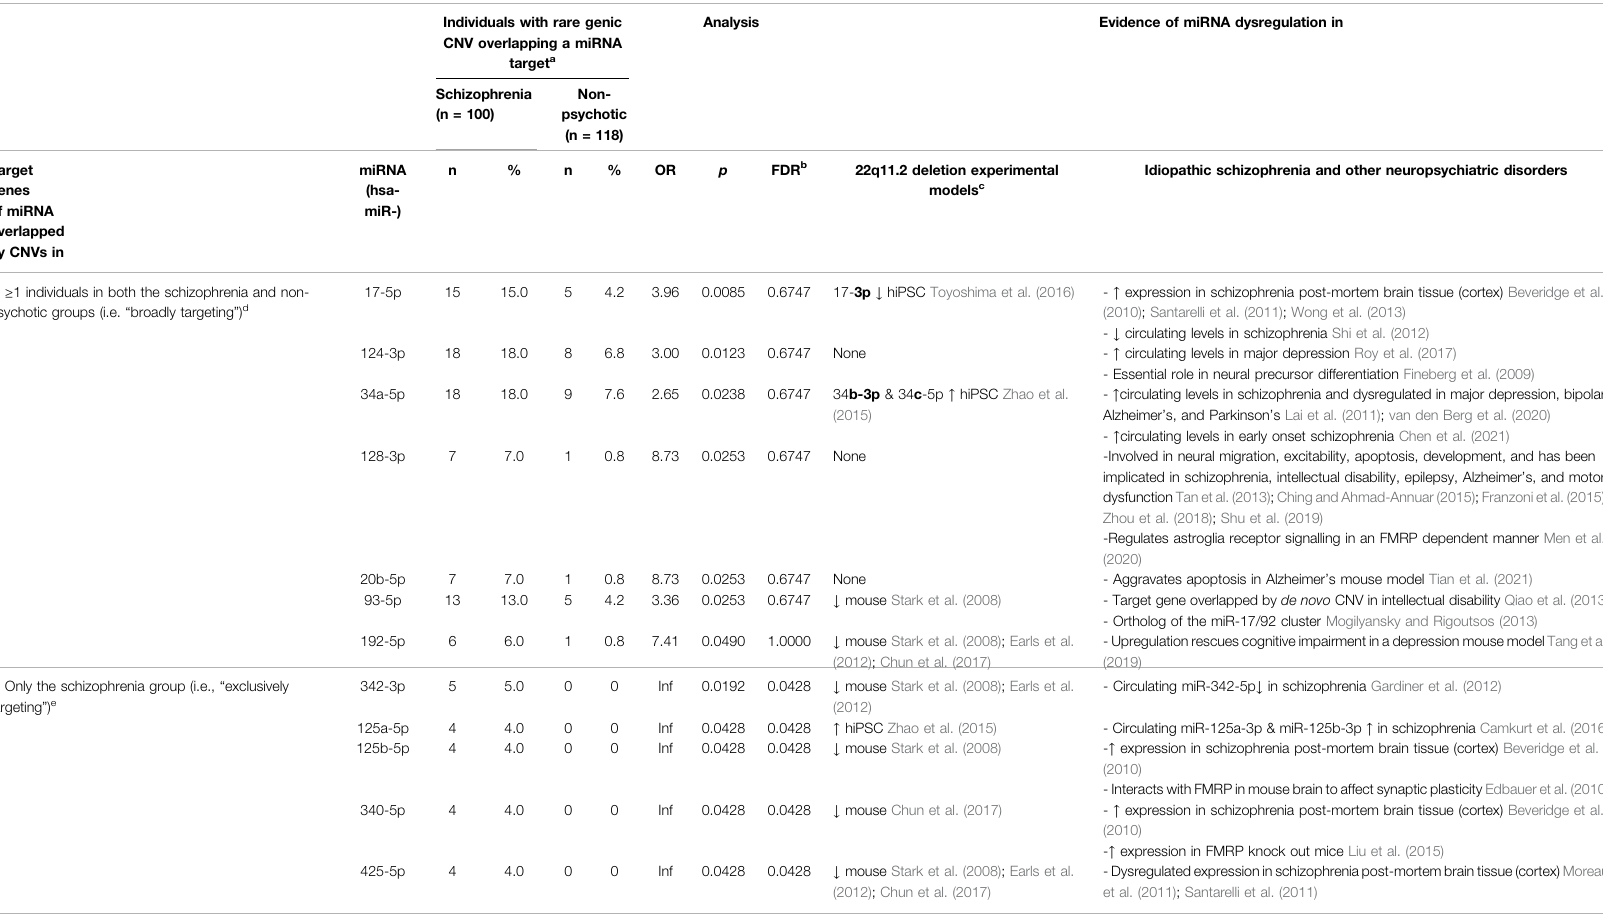
TABLE 2 | miRNAs with target genes overlapped by rare CNVs in signi fi cantly more individuals in the 22q11.2DS schizophrenia group than in the 22q11.2DS non-psychotic group.